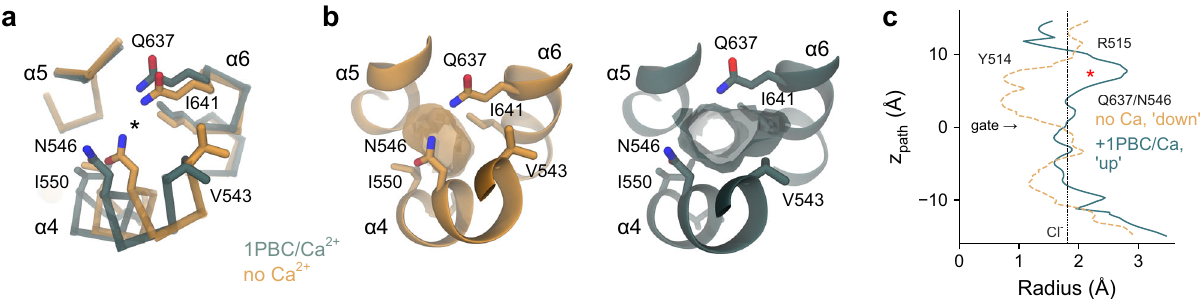
Fig. 7 Pore conformation. a Superposition of the narrow neck region of the hourglass-shaped pore of the rebuilt Ca 2 + -free apo (PDB: 5OYG) and the 1PBC/Ca 2 + -bound structures viewed from the top. Asterisk indicates the pore axis. b Molecular surface of the neck region viewed from the top. Selected residues lining the volume are shown. c Pore radius along the z-axis relative to the position of Ile 641 (gate). The locations of constrictions are indicated. Asterisk indicates the location of the 1PBC binding site. Dashed line denotes the ionic radius of a Cl